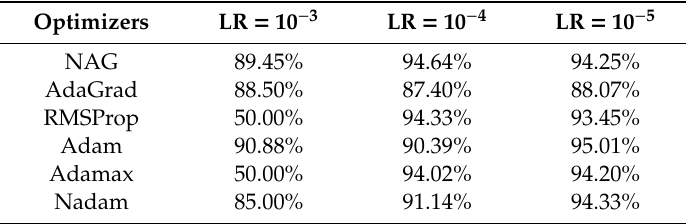
Table 2. Results obtained with the VGG16 architecture. Where LR stands for learning rate; NAG represents Nesterov momentum; AdaGrad represents the adaptive gradient optimizer; RMSProp represents the root mean square propagation optimizer; Adam represents adaptive moment estimation optimizer; AdaMaxrepresentsmaximumadaptivemomentestimationoptimizer; andNadamrepresents Nesterov and Adam optimizer.